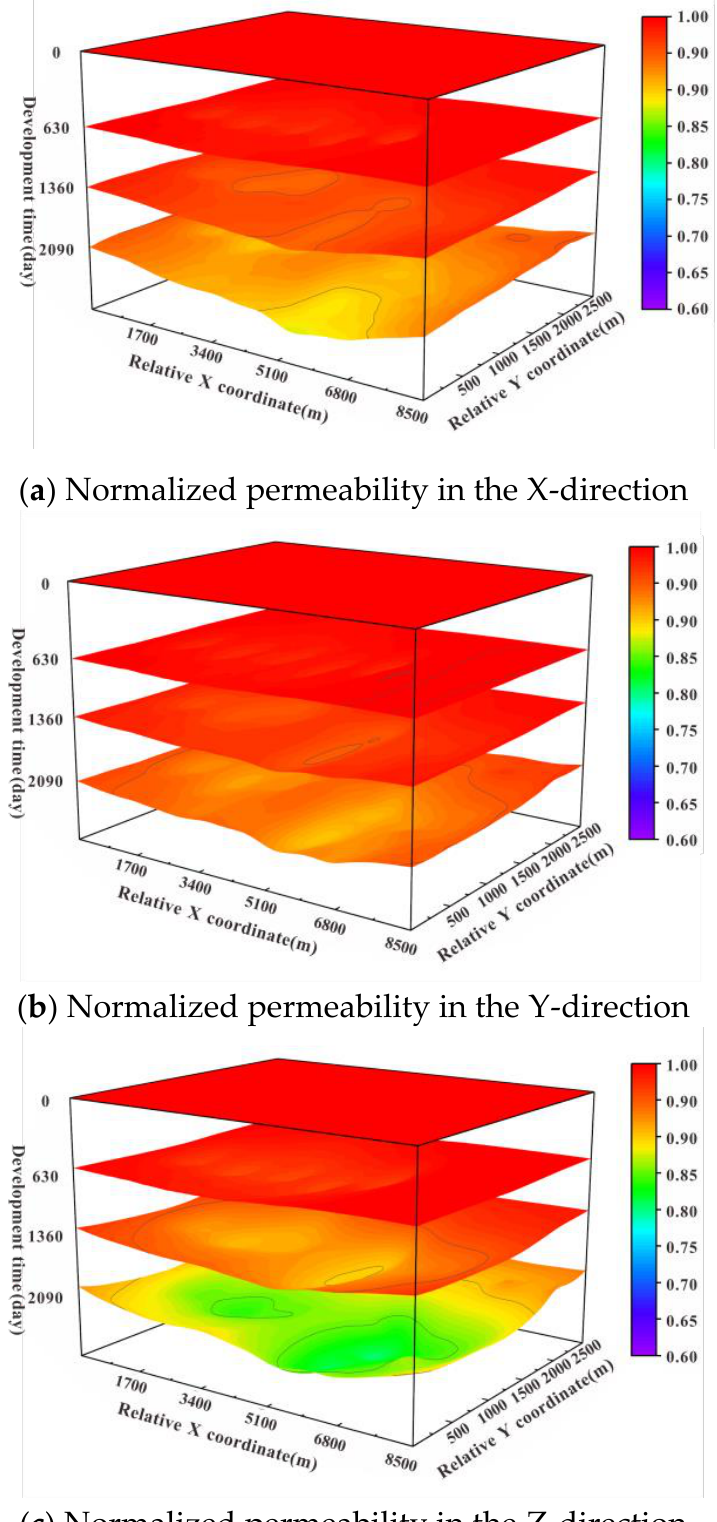
Figure 17. Normalized permeability contours of matrix systems.